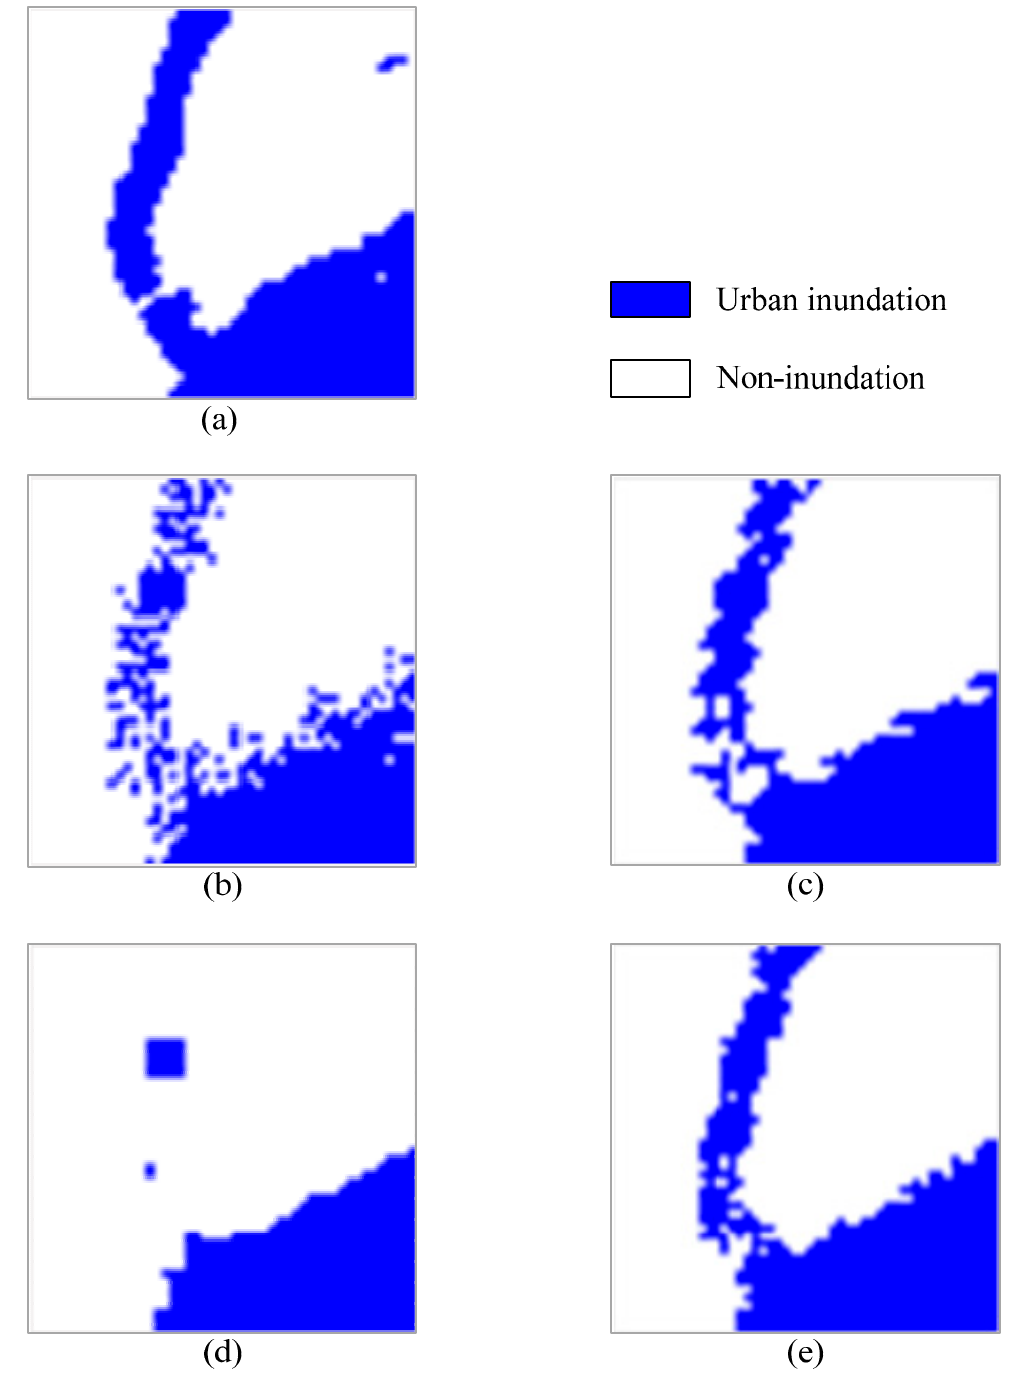
Figure 7. Zoom for small part 2 of inundation reference image and different SUIM results for Wuhan. ( a ) Inundation reference image; ( b ) BPNN ‐ SUIM; ( c ) SVM ‐ SUIM; ( d ) SAM ‐ SUIM; ( e ) SAMENN ‐ SUIM.